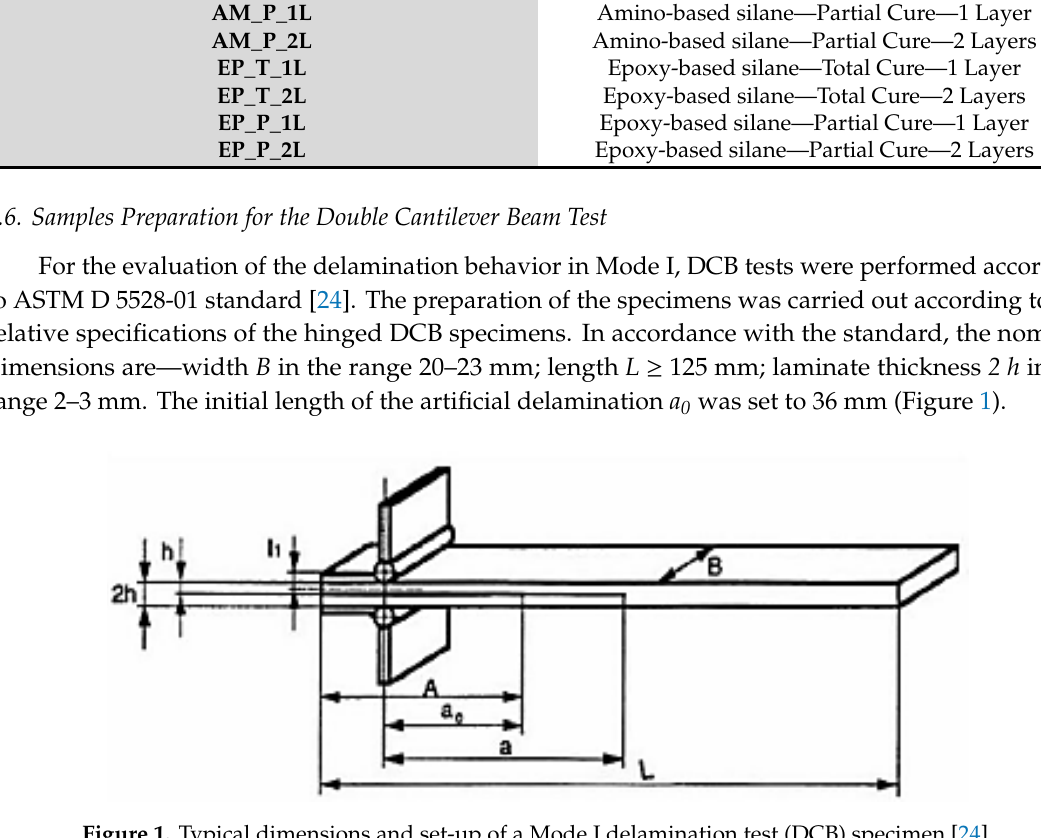
Figure 1. Typical dimensions and set-up of a Mode I delamination test (DCB) specimen [24].